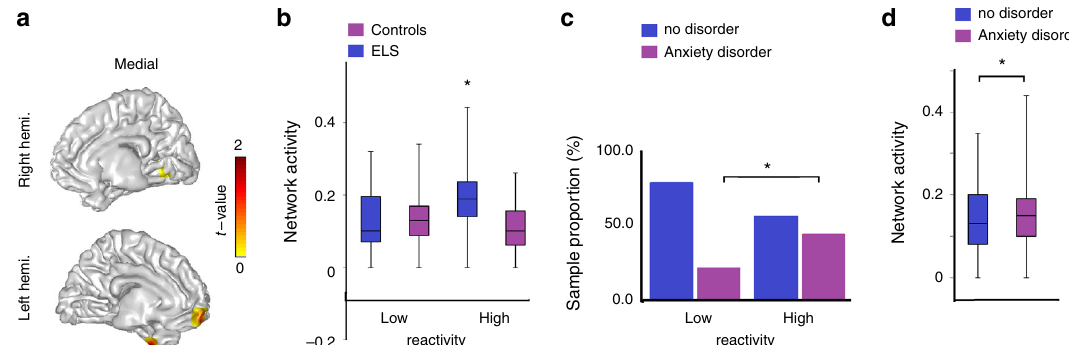
Fig. 3 Characterizing the Putative Mentalizing activity. a ELS preadolescents activated the putative mentalizing network in T4 signi fi cantly stronger than controls did (masked for P cluster-cor < 0.05), and the color bar conveys masked t values. b Power averages over the network nodes were signi fi cantly different between the two groups, particularly those with high negative reactivity in T1. c Individuals with high negative reactivity in T1 developed more internalizing disorders in T3. d Internalizing disorders in T3 explained that mentalizing neural activity, in T4. In the chart bars, points are laid over a SEM (95% con fi dence interval), and asterisks convey statistically signi fi cant effects